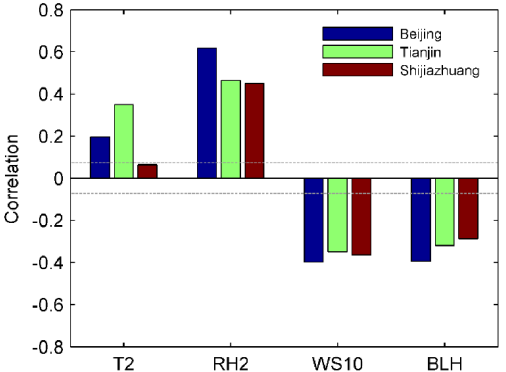
Figure 3. The correlation between daily average PM 2 . 5 concen- trations and daily average meteorological parameters during 2014– 2015. The dashed lines represent the critical correlation coefficient that passes the t test at a 95% confidence